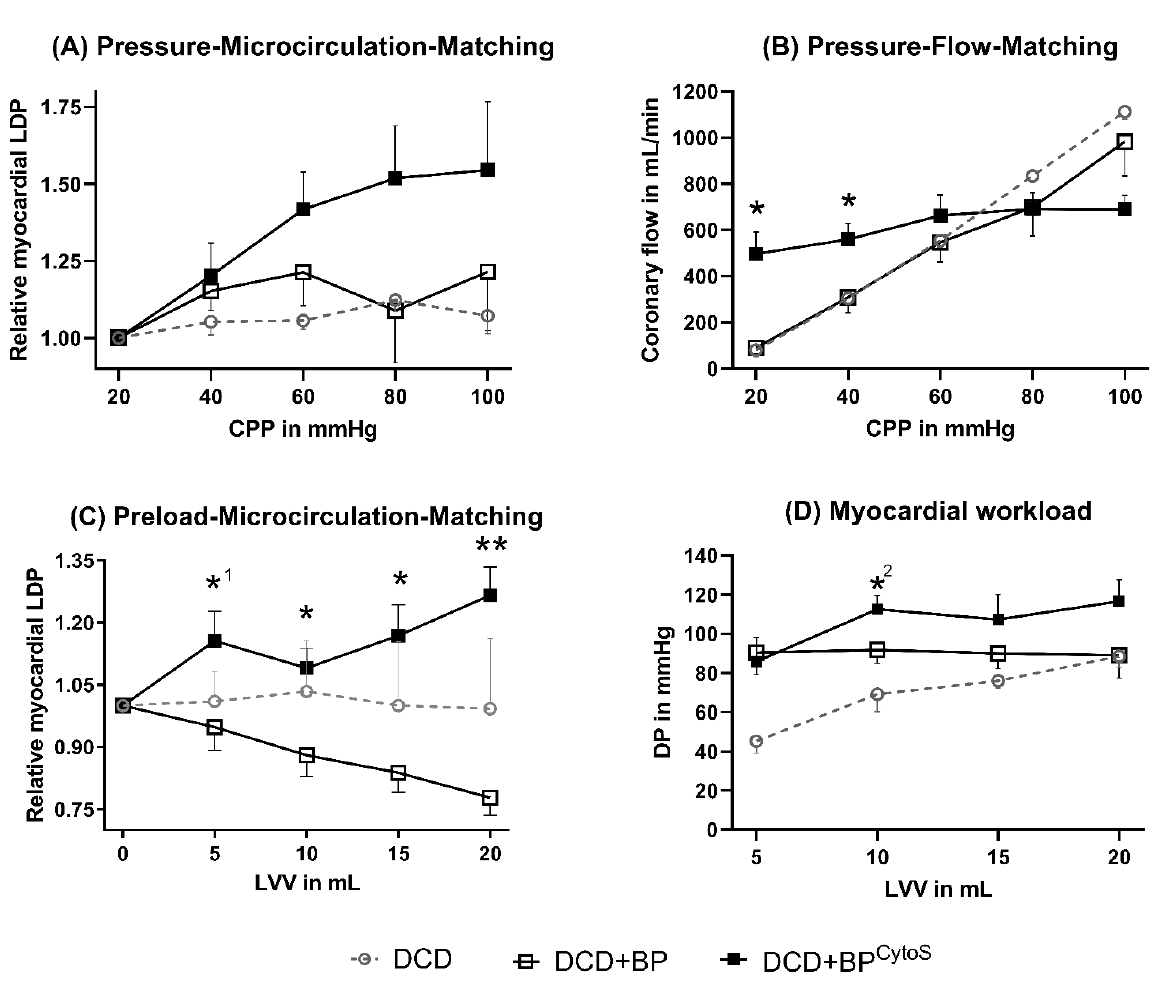
Figure 2. Microvascular function. ( A ) Pressure-Microcirculation-Matching. ( B ) Pressure-Flow- Matchig. ( C ) Preload-Microcirculation-Matching. ( D ) Myocardial workload * p < 0.05, * 1 p = 0.053, * 2 p = 0.067 and ** p < 0.001 compared to DCD-BP. LDP in DCD hearts is only shown as a reference.